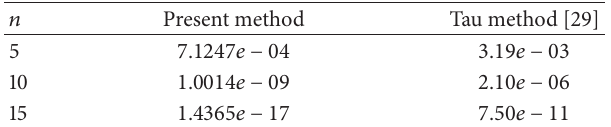
Table 6: Comparison of absolute maximum errors for Example 4 at different 𝑛